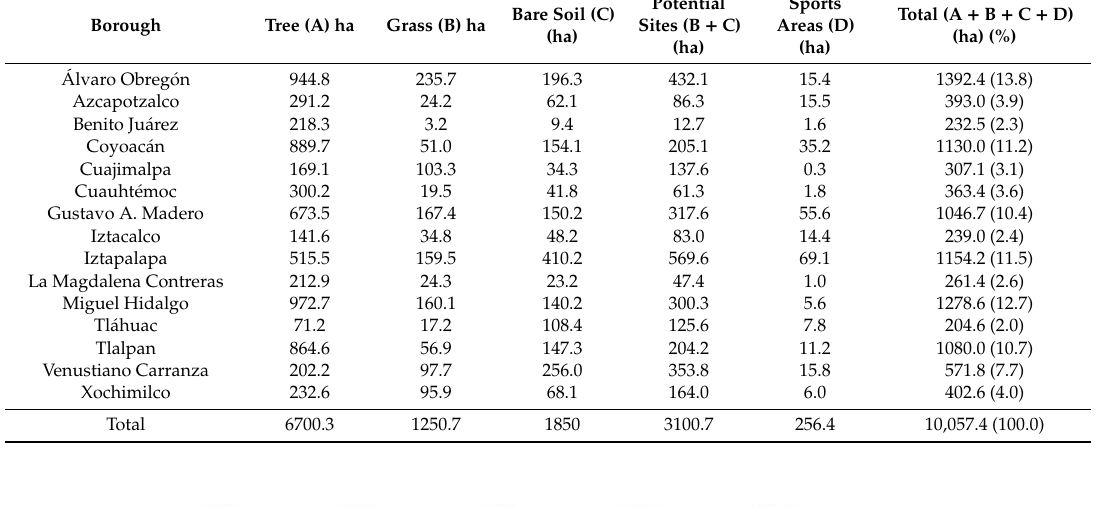
Table 3. Potential planting area and total green area in Mexico City’s boroughs.